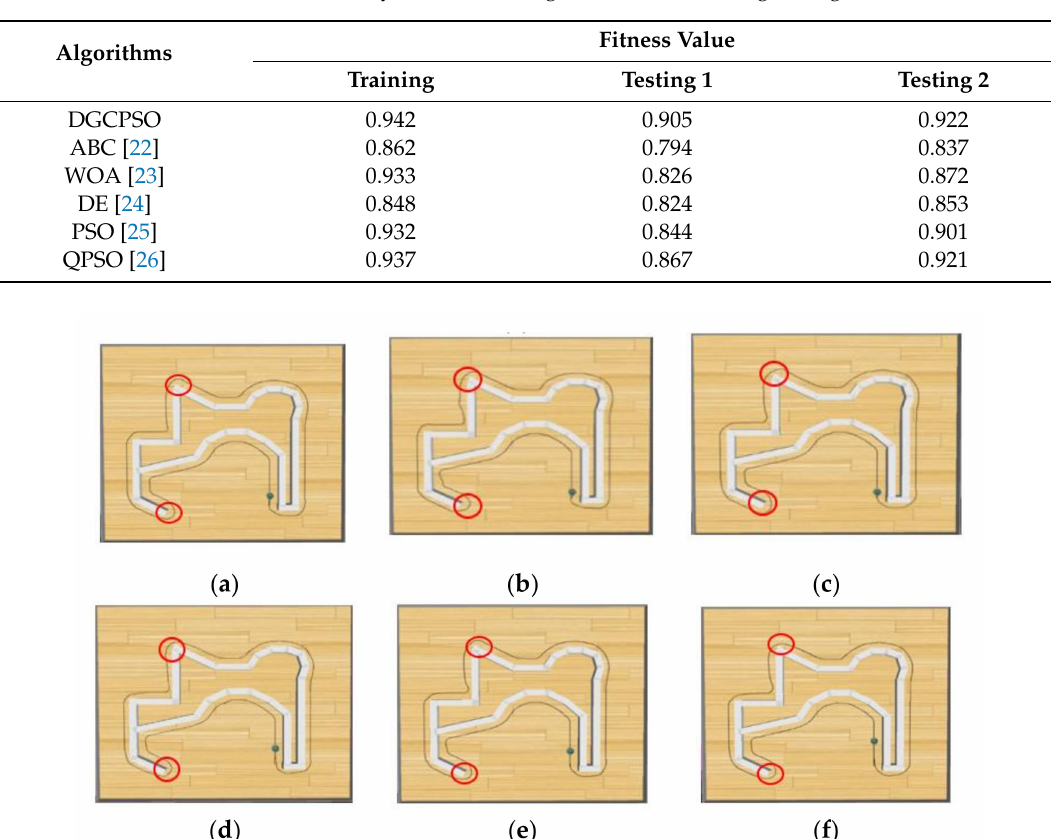
Figure 21. Moving path of setting 2 of ( a ) DGCPSO, ( b ) ABC [22], ( c ) WOA [23], ( d ) DE [24], ( e ) PSO [25], and ( f ) QPSO